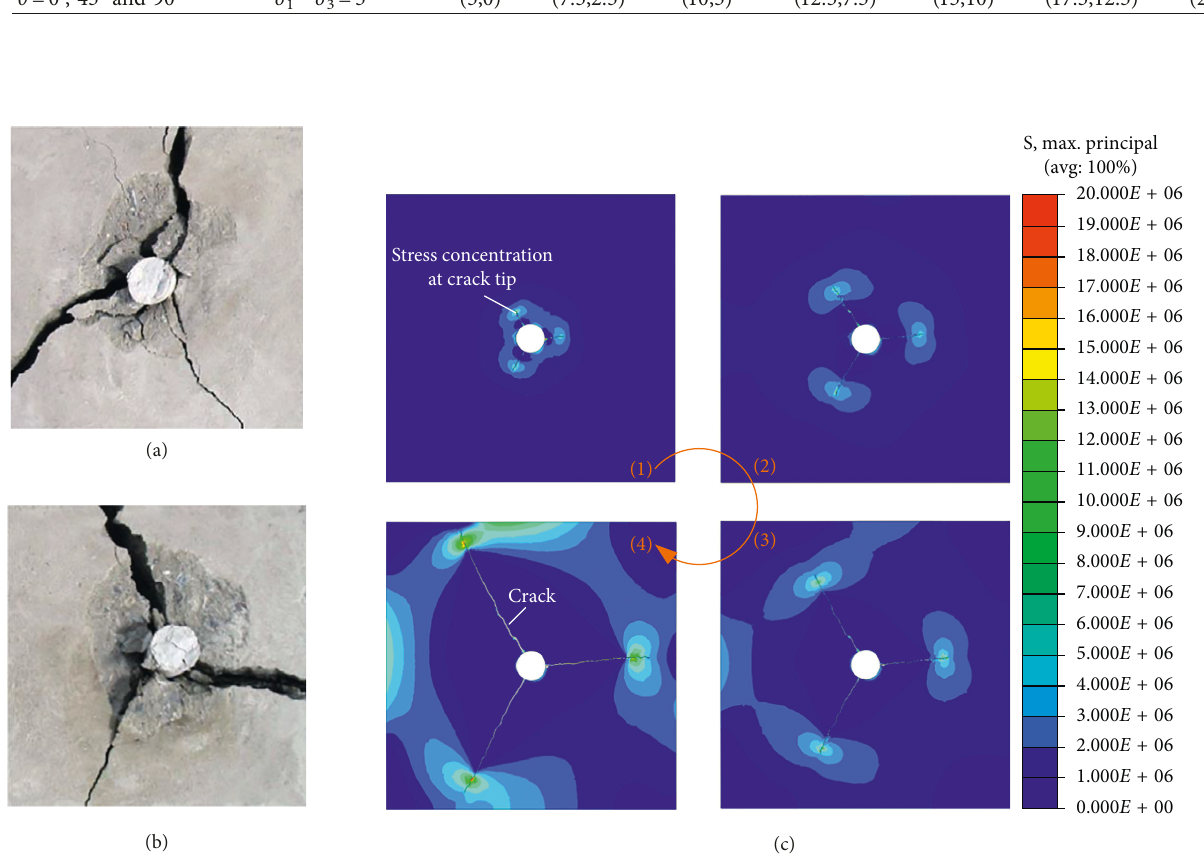
Figure 12: The SCA-induced crack characteristics of the experiment results and that of the numerical results under the free boundary conditions. (a) and (b) show the experiment results of Tang et al. [10]. (c) shows the numerical